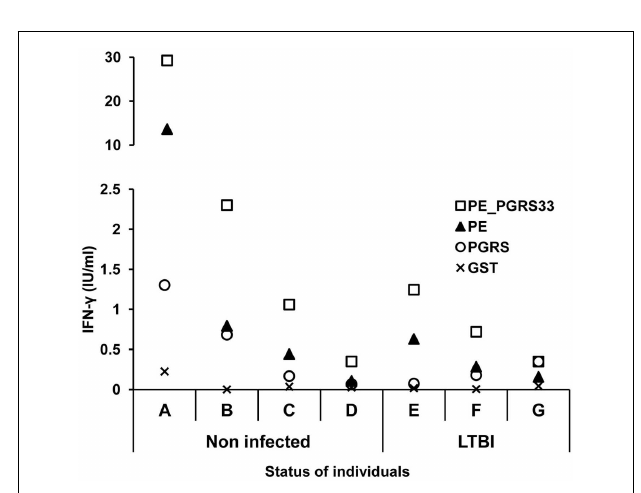
FIGURE 4 | INF- γ response to the PE_PGRS33 and its PE and PGRS domains in LTBI and non-infected individuals. Diluted whole blood cells were stimulated with 25 µ g of PE_PGRS33, PE, PGRS, or GST protein plus 10 µ g/ml of polymyxin B for 6days. IFN- γ in the supernatants was quantified using the Human IFN- γ ELISA kit provided with the QuantiFERON®-TB Gold Kit. Letters represent each individual tested and symbols correspond to the amount of IFN- γ produced by each of